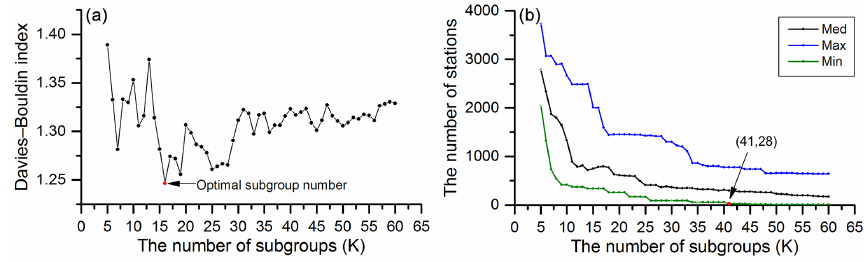
Figure 5. Optimal K selection by (a) DB index and (b) the number of stations in subgroups during delineation. Table 3. The impact of clustering factors on regional 100-year flood